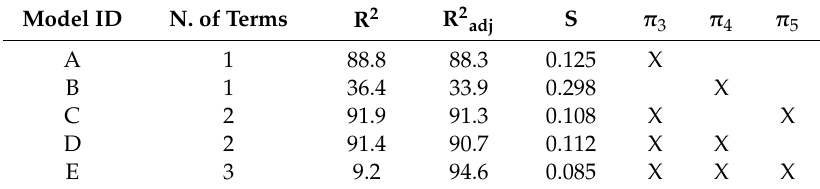
Table 6. Best subsets regression for 1